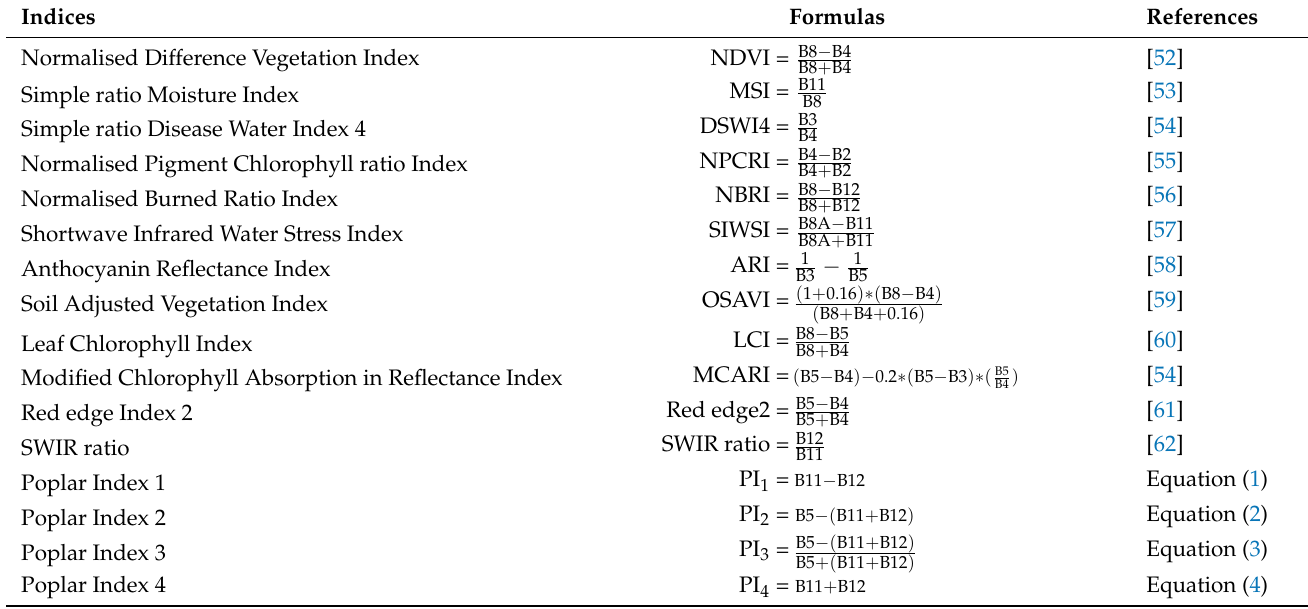
Table 3. List of the spectral indices compared with the corresponding formulas and